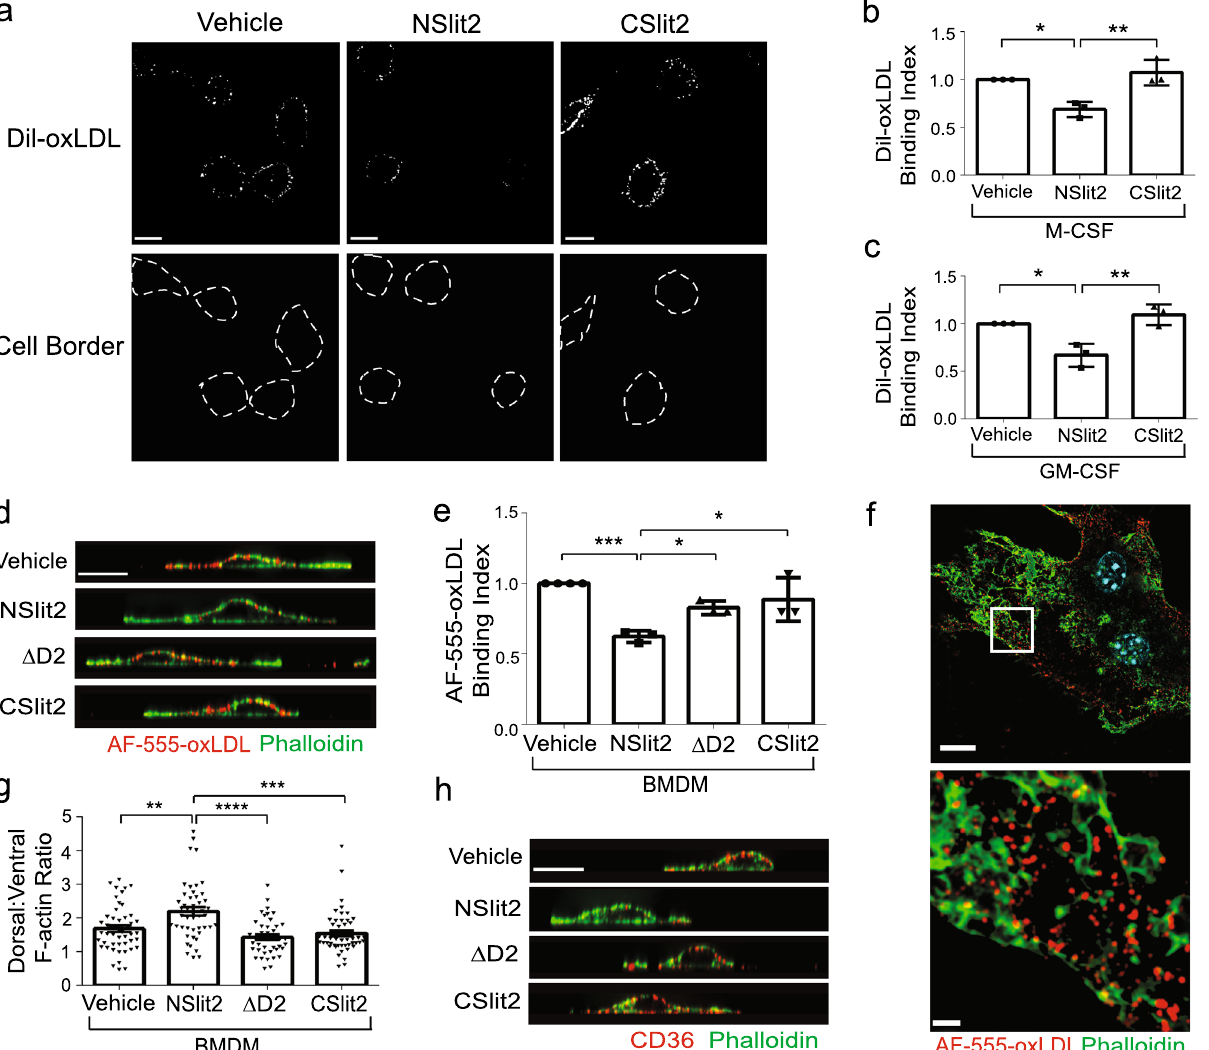
Figure 4. NSlit2 inhibits binding of oxLDL to the surface of macrophages by depleting actin-poor zones in which CD36 clusters. ( a ), M-CSF-induced human macrophages were incubated with vehicle, NSlit2, or CSlit2, followed by a 1 min incubation with DiI-oxLDL at 37 °C. Cells were washed to remove unbound DiI-oxLDL and then fixed. Representative images were obtained using a spinning disk confocal microscope. Cell borders are indicated via dashed lines (bottom row). Scale bar, 10 μm. ( b ), Quantification of ( a ). For each experimental condition, the MFI of bound DiI-oxLDL was quantified for 20–40 cells using Image J Software. Data are the mean ± SEM of 3 independent experiments. ( c ), Experiments were performed as in ( b ), using GM-CSF-induced macrophages. Data are the mean ± SEM of 3 independent experiments. ( d ) BMDM were incubated with vehicle, NSlit2, CSlit2, or ΔD2, then incubated with AF-555-conjugated oxLDL (red) for 1 min at 37 °C. Cells were fixed and incubated with AF-488-conjugated phalloidin (green). Representative XZ slices were obtained using a spinning disk confocal microscope. Scale bar, 10 μm. ( e ), Quantification of experiments performed in ( d ). For each experimental condition, the MFI of bound AF-555-conjugated oxLDL was quantified for 20–40 cells using Image J Software. Data are the mean ± SEM of 3–4 independent experiments. ( f ), Experiments were performed as in ( d ), and super resolution, Structured Illumination Microscopy (SIM) used to obtain representative XY optical slices. Scale bars; 15 μm (top), 2 μm (bottom). ( g ), Quantification of experiments performed in ( d ). The dorsal:ventral F-actin ratio was quantified using ImageJ Software to measure the fluorescence intensity of AF-488-conjugated phalloidin and 30–40 cells were analyzed for each experimental condition. Mean ± SEM from 4 to 5 independent experiments. ( h ) , BMDM were incubated with vehicle, NSlit2, CSlit2 or ΔD2, then fixed and incubated with anti-CD36 Ab followed by AF-647-conjugated anti-rat IgG (pseudocoloured red) and AF-488-conjugated phalloidin (green). Representative XZ slices were obtained using a spinning disk confocal microscope. Scale bar, 10 μm. For ( b ), ( c ), ( e ), ( g ) * p < 0.05, ** p < 0.01, *** p < 0.001, **** p < 0.0001 were determined by one-way ANOVA using Tukey’s post hoc